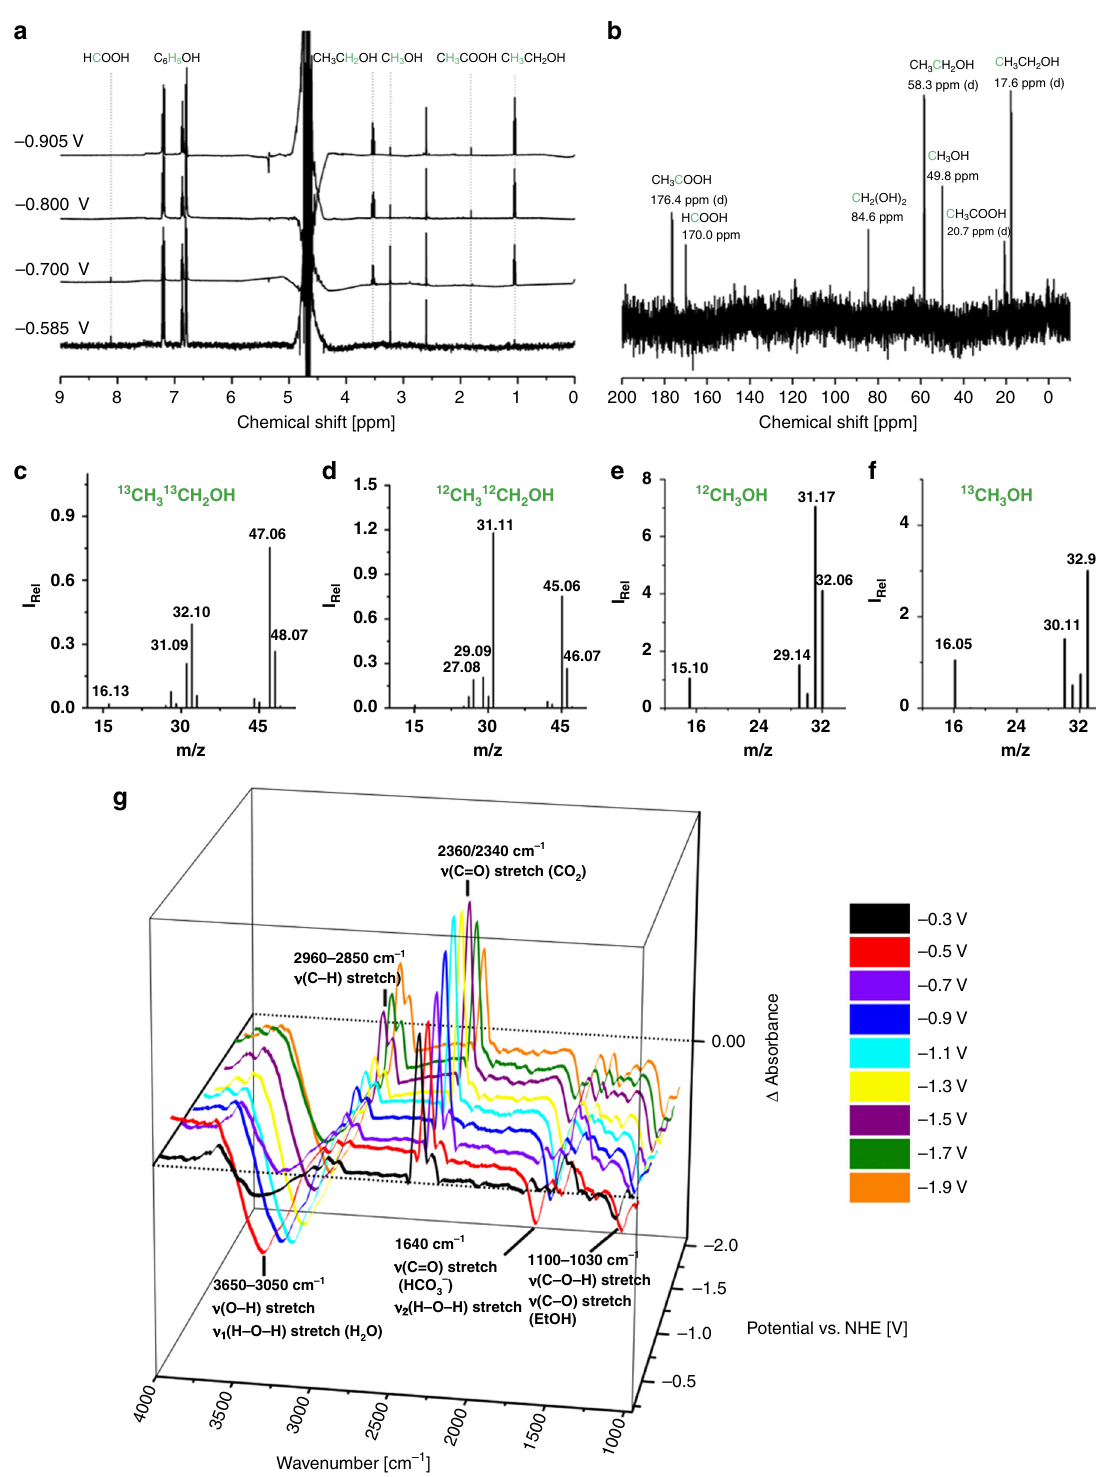
Fig. 3 a 1 H-NMR spectrum of the electrolyte after 5 h of CO 2 electrolysis over Co-corrole – carbon paper electrode at − 0.585, − 0.7, − 0.8, and − 0.905 V vs. RHE in 0.1 M NaClO 4 , pH = 6, phosphate buffer, and phenol as the internal standard in DMSO. b 13 C-NMR (101 MHz, H 2 O:D 2 O = 5:1) of the electrolyte after 5 h of electrolysis at − 0.8 V vs. RHE in 13 CO 2 , 0.1 M NaClO 4 , pH = 6, phosphate buffer. c – f GC – MS spectrum of the electrolyte after bulk electrolysis at − 0.8 V vs. RHE in 12 CO 2 and 13 CO 2 : c 13 C enriched ethanol, d 12 C enriched ethanol, e 12 C enriched methanol, and f 13 C enriched methanol. g SEC-FTIR spectra during the CO 2 reduction with 20 mM Co-corrole in 0.1 M TBAPF 6 (in CH 3 CN/H 2 O = 4:1), at potentials from − 0.3 to − 1.9 V vs.